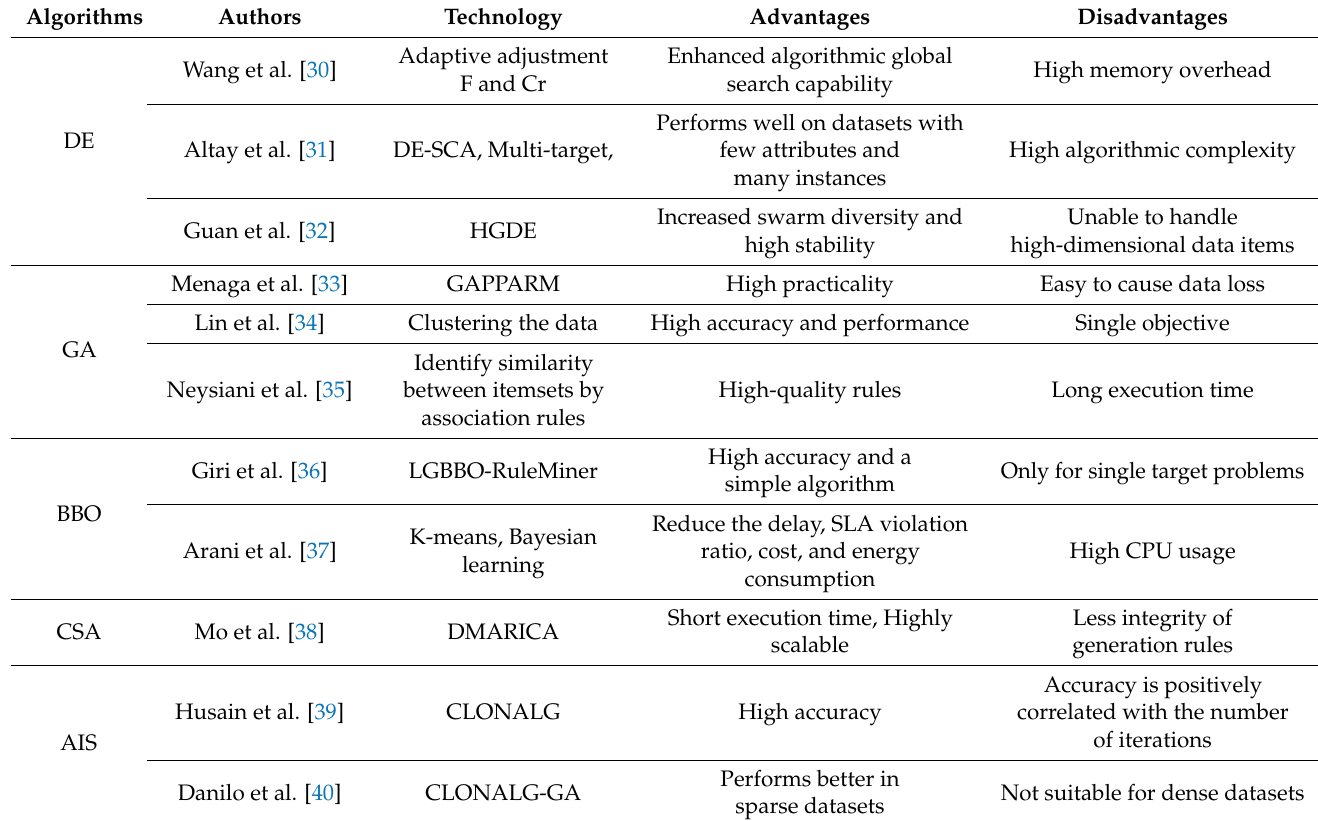
Table 1. ARM, based on evolutionary algorithm.